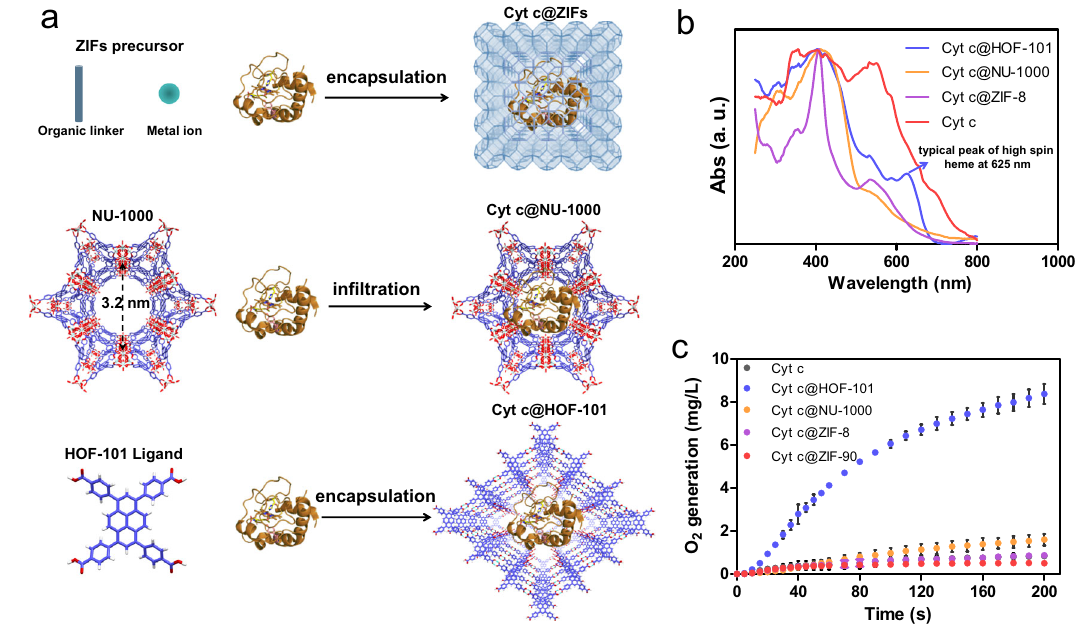
Fig. 4 | The key role of the designed net-carboxylate-arranged cage for con- formational modulation. a Schematic illustration of the synthesis of Cyt c@ZIFs, Cyt c@NU-1000 and Cyt c@HOF-101. The colors used in NU-1000 are: red for O atom; blue for C atom; light green for Zr atom; H atom is removed for clarity. The colorsused inHOF-101 are: red for O atom; blue for C atom; white forH atom. The